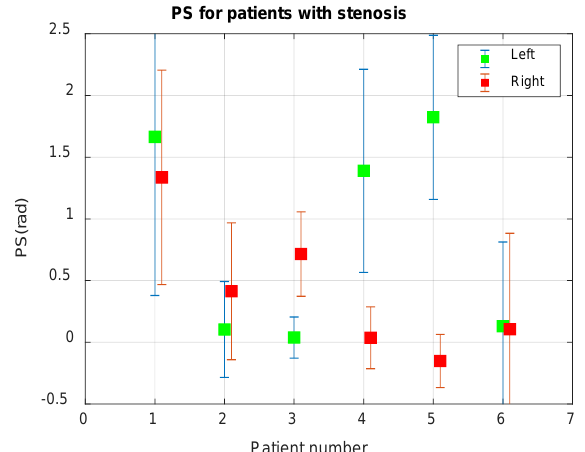
Figure 6. Average phase shift (PS) between the BP and BFV signals in the Mayer waveband in 6 patients with carotid stenosis.